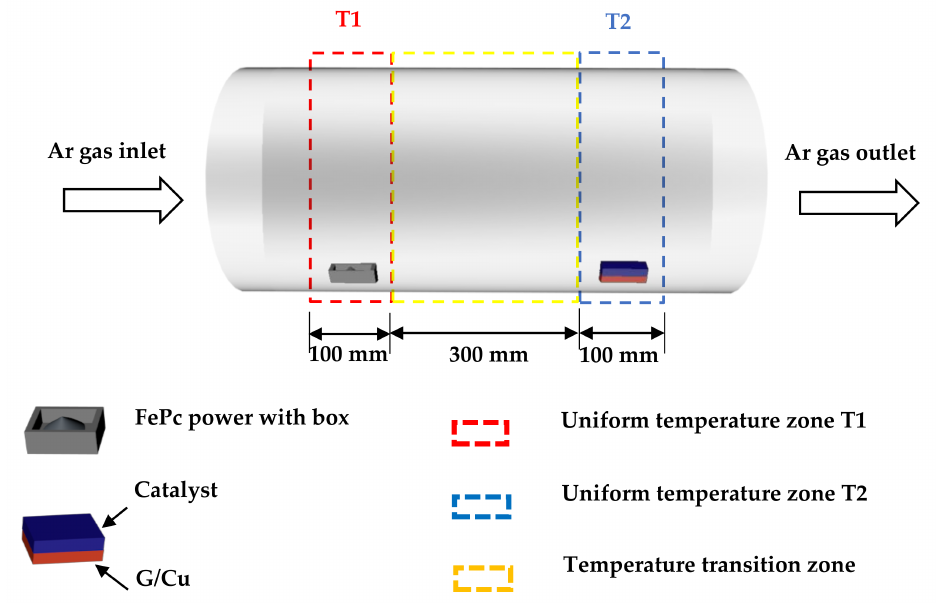
Figure 1. Schematic view of the tube furnace used to synthesize the